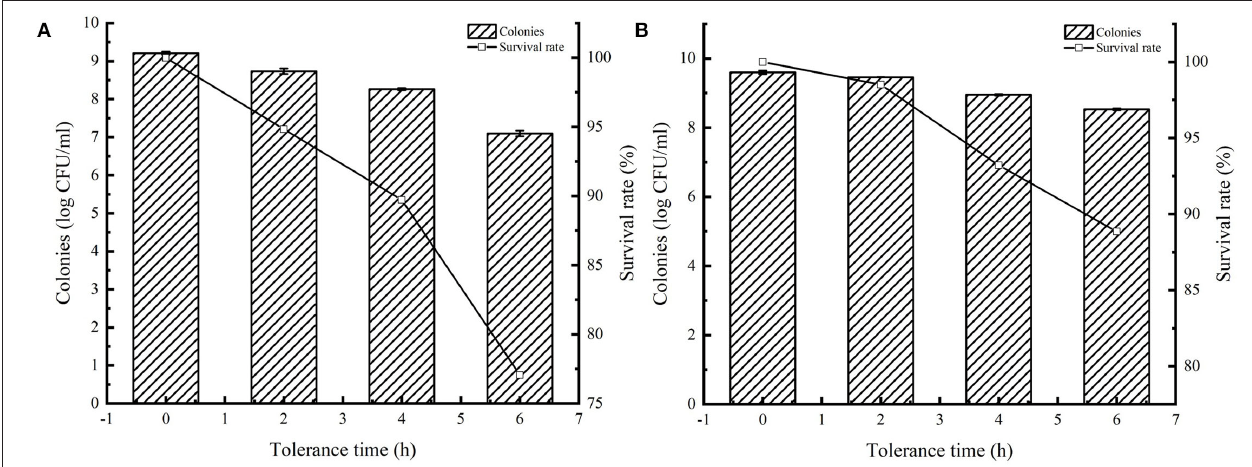
FIGURE 7 | Tolerance of Lactobacillus acidophilus CICC 6074 strains in artificial intestinal juice. Survival of L. acidophilus CICC 6074/pMG36e recombinant strain after tolerance in artificial intestinal juice (A) . Survival of L. acidophilus CICC 6074/pMG36e-AI-2E recombinant strain after tolerance in artificial intestinal juice (B) .